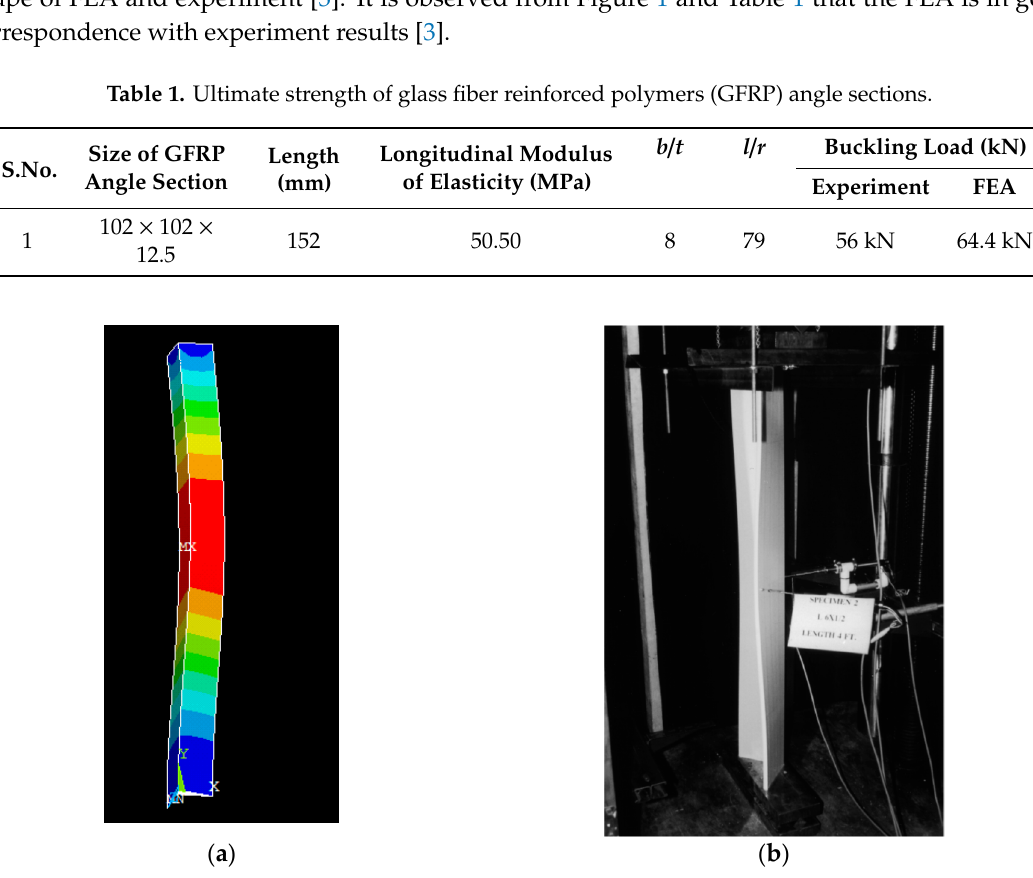
Figure 1. Buckling mode shape validation ( a ) Finite Element Analysis; ( b ) experiment Zureick and Steffen [3] . Table 1. Ultimate strength of glass fiber reinforced polymers (GFRP) angle sections .